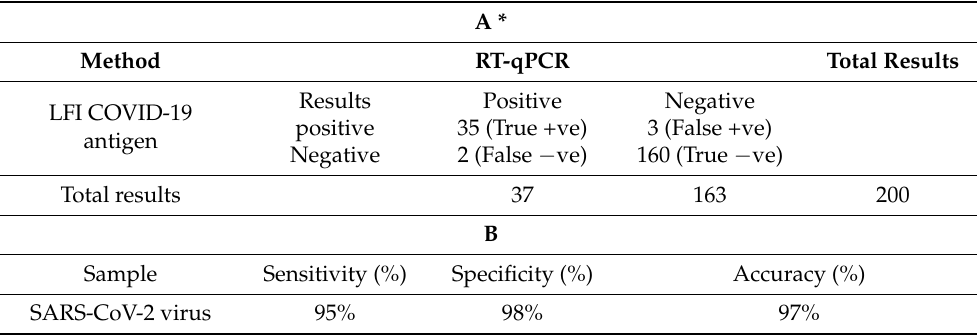
Table 2. The relative sensitivity, specificity and accuracy of the developed LFI COVID-19 antigen test, as compared with the RT-PCR commercial